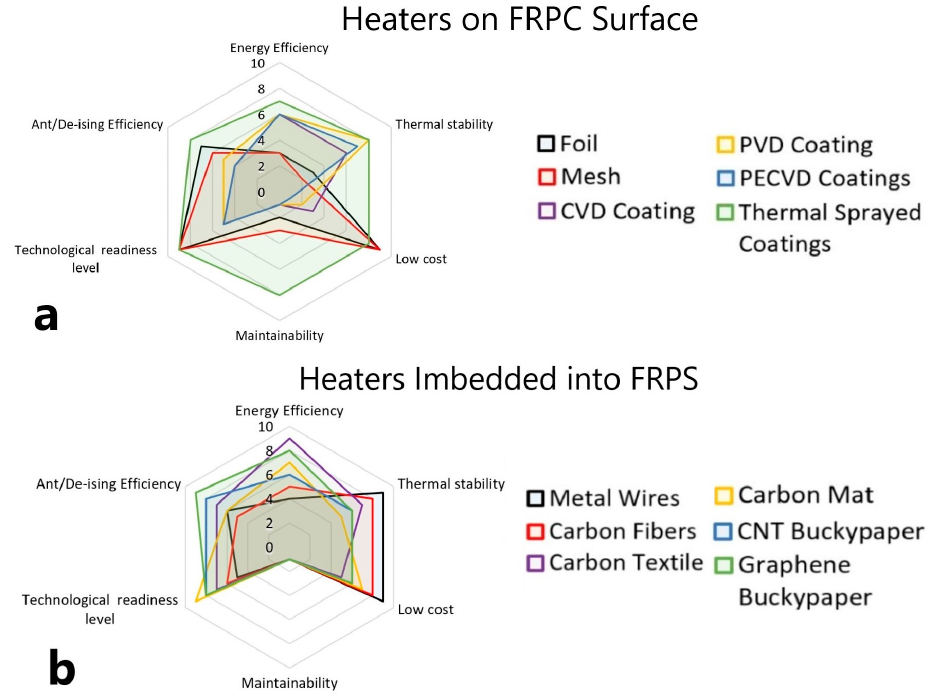
Figure 10. Comparison of the efficiency of heaters ( a ) placed on FRPC surface, and ( b ) embedded into FRPC, fabricated by different technologies. Table 1. Properties of FRPC